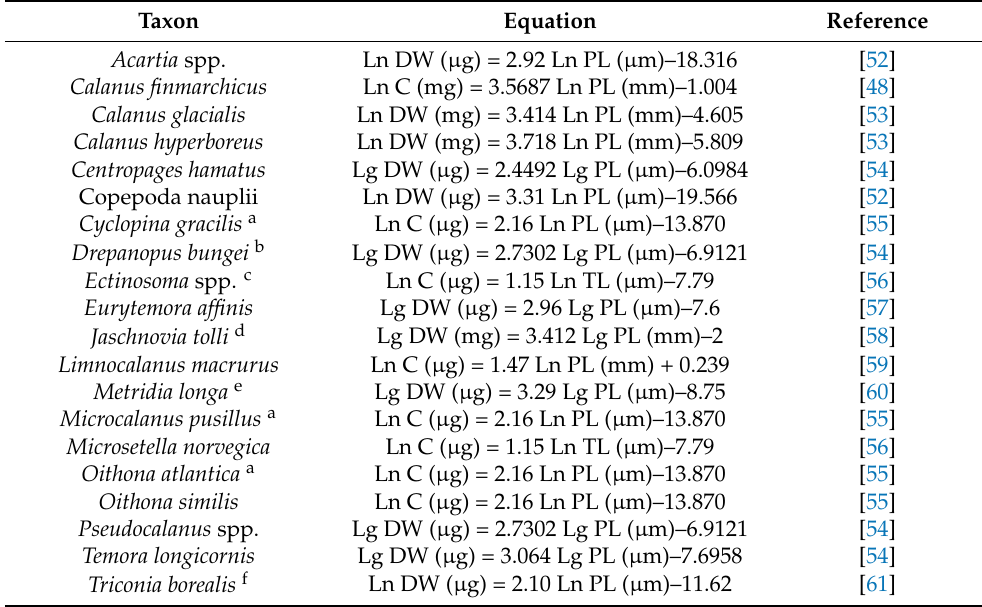
Table 2. Length–weight regressions used to calculate biomass of copepod taxa in the south-eastern Bar- ents Sea in summer 2012. PL—prosome length, TL—total length, DW—dry weight, C—carbon